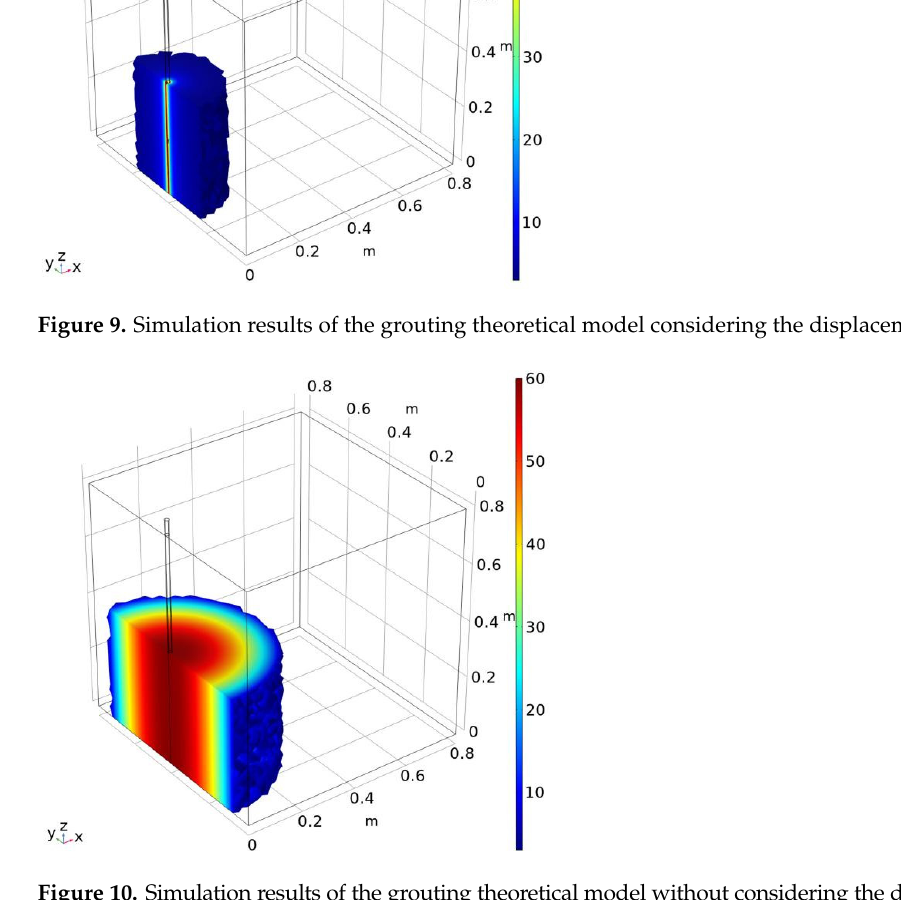
Figure 10. Simulation results of the grouting theoretical model without considering the displacement effect.